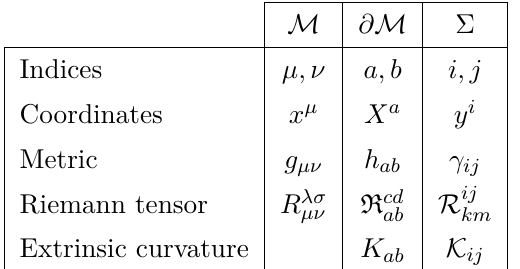
Table 2 . Notation for the geometric objects indicated in the first column, for the different manifolds considered in the first